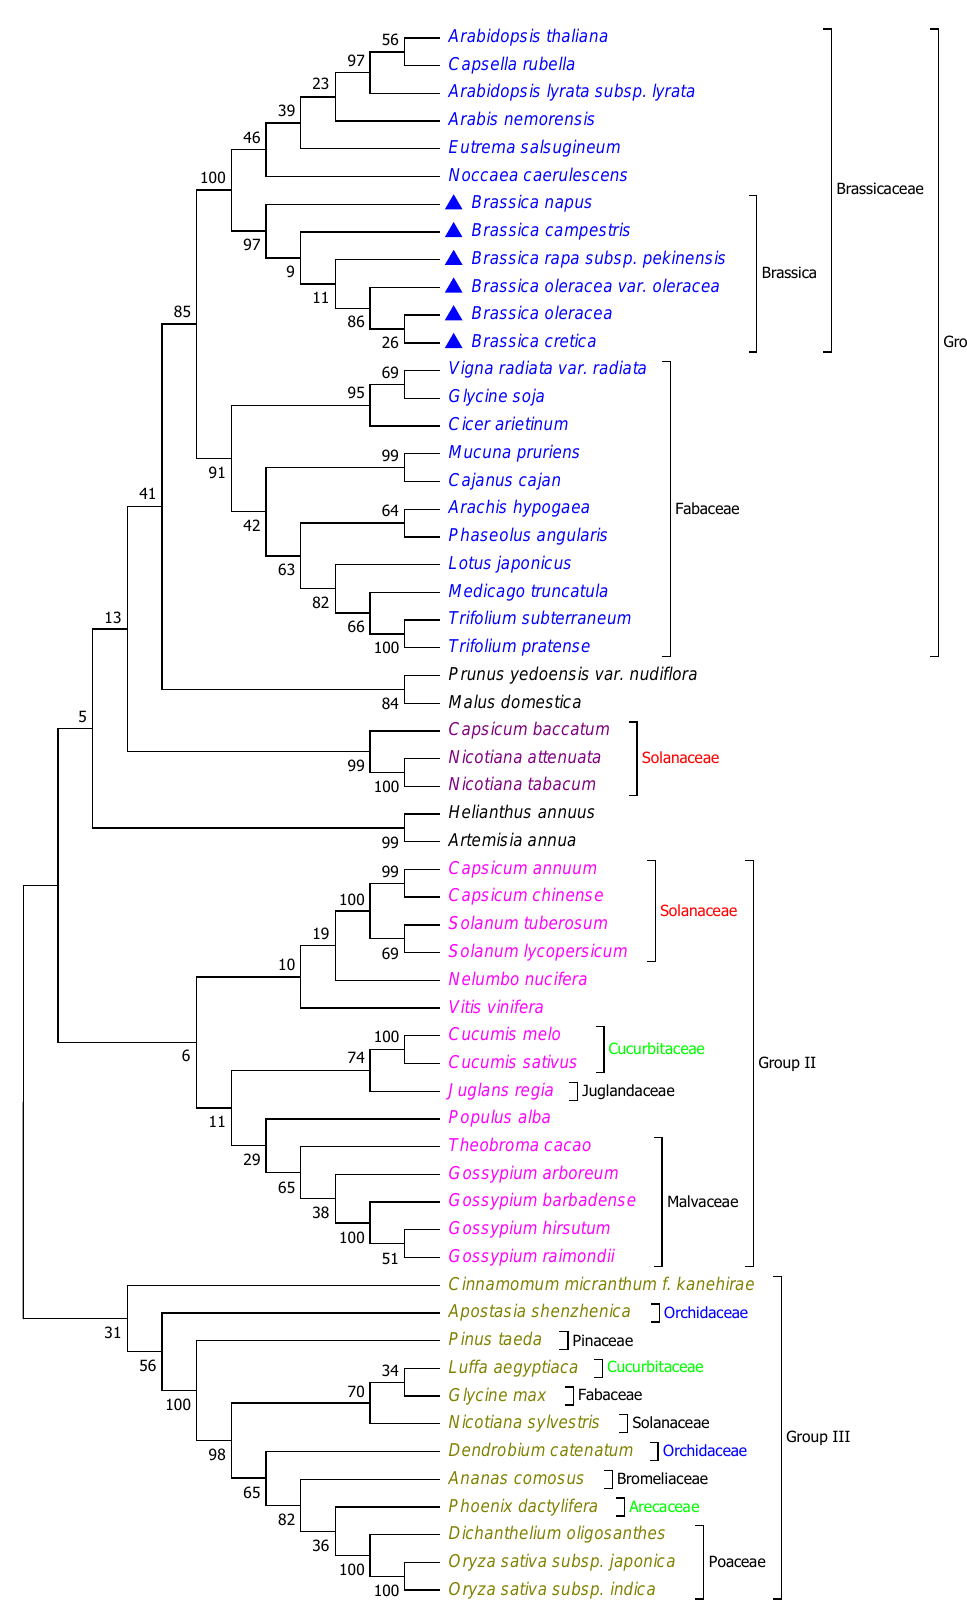
Figure 7. Phylogenetic relationship of EXLB1 of B. rapa and other species. The phylogenetic tree was constructed with maximum likelihood algorithm with 1000 bootstrap replicates using MEGA 7.0 tool.